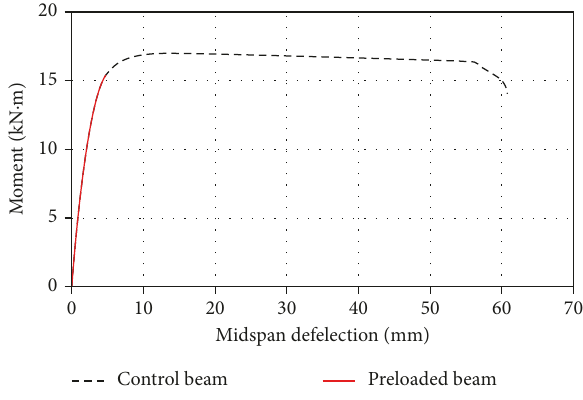
Figure 12: Typical moment versus midspan deflection curve of preloaded